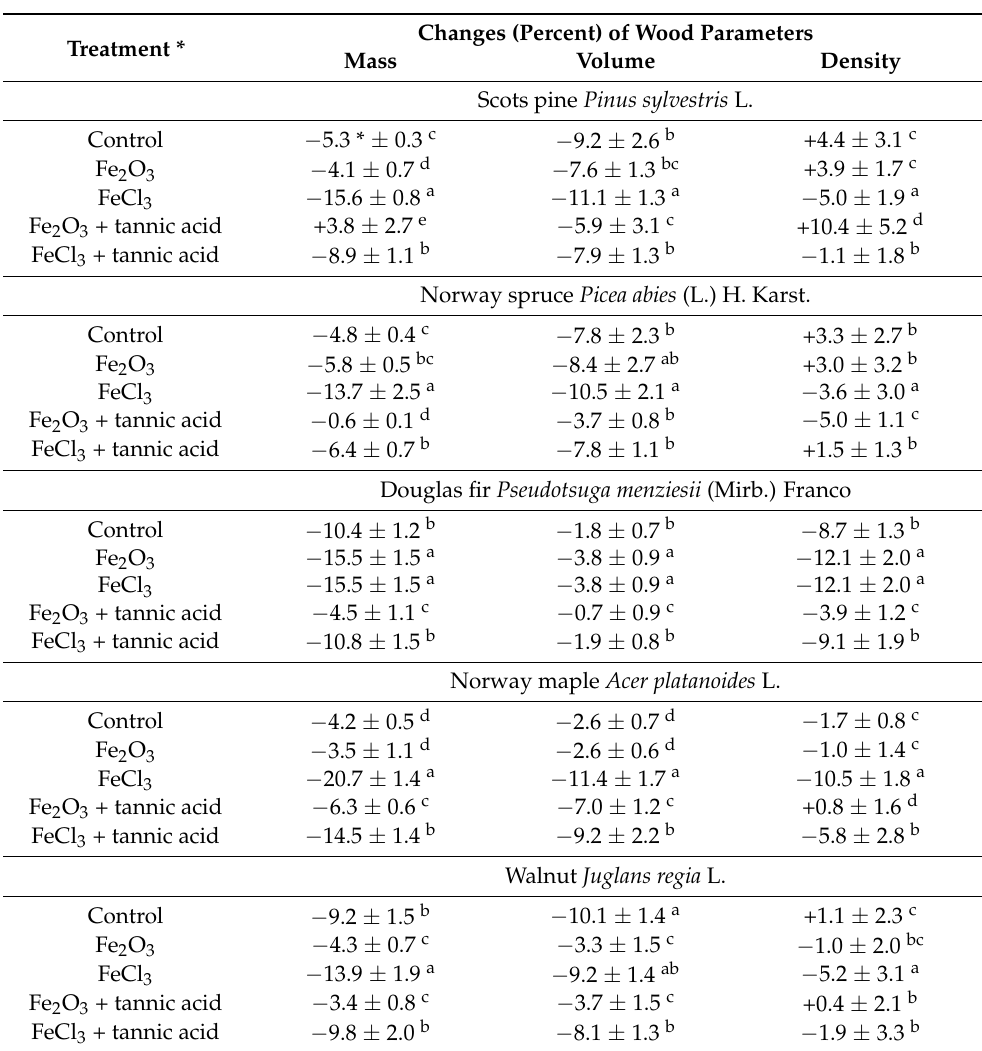
Table 1. Changes of wood mass, volume and density after treatment. Different letters a, b, c, d and e given next to the mean value show statistically significant differences between the treatments for each tree species at p < 0.05 ( n =